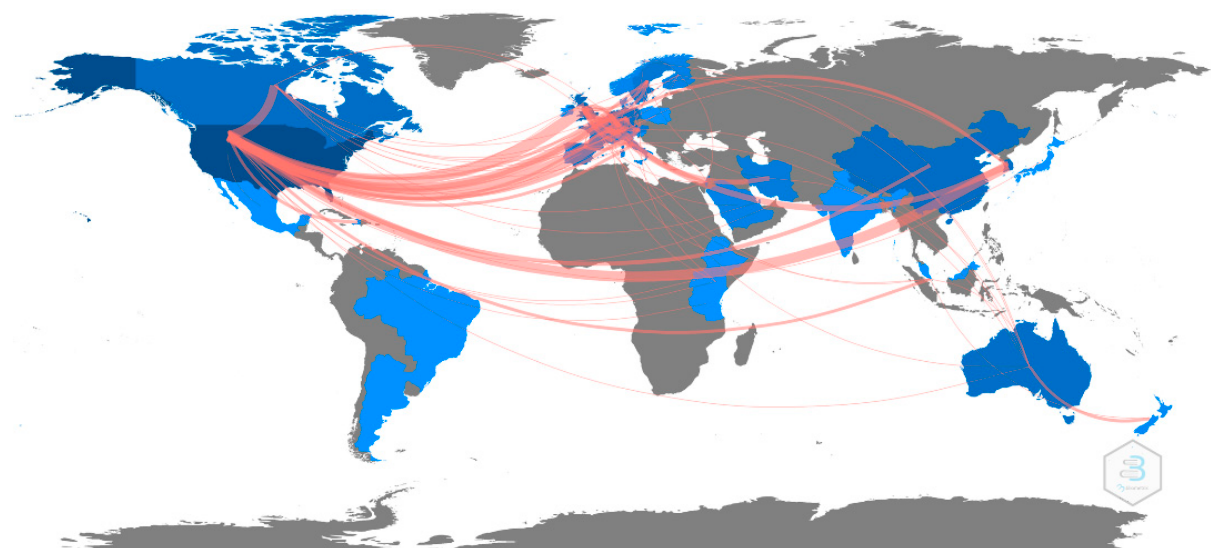
Figure 4. The country collaboration map for CDSS alert studies.